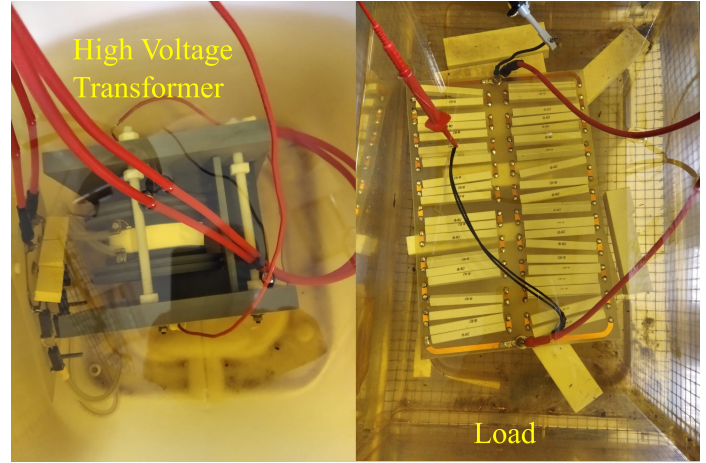
Figure 19. Illustration of the high-voltage prototype.